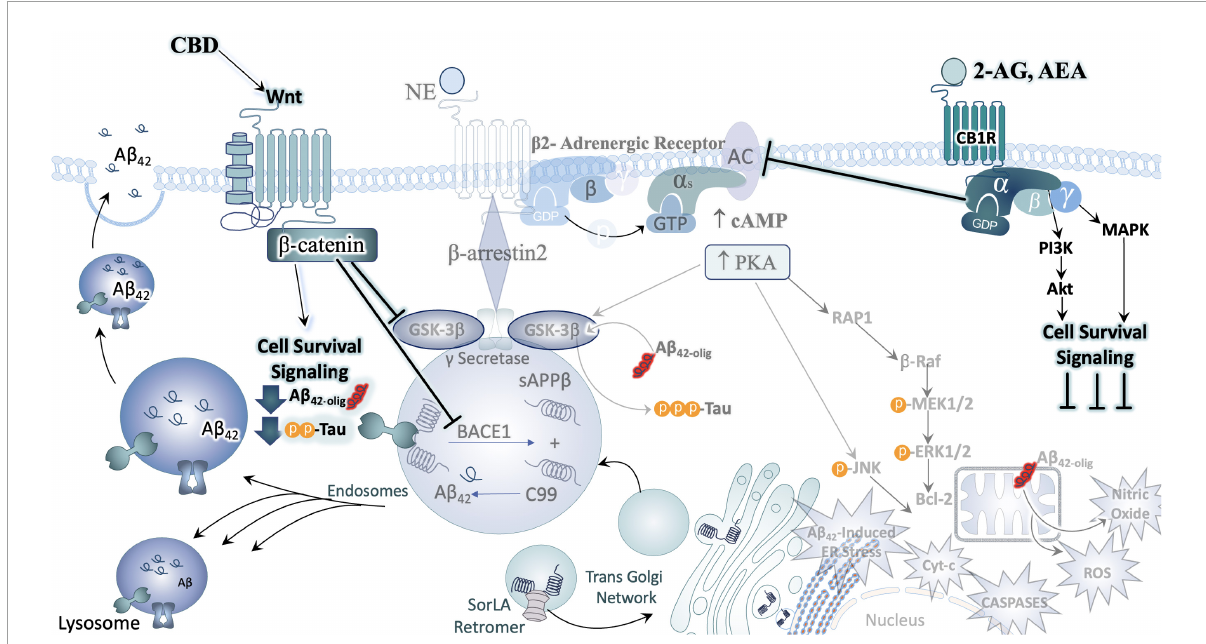
FIGURE6 Cannabinoids counteract AD neuropathology exacerbated by stress. In direct opposition to (chronic) stress-responsive intracellular signaling cascades such as those downstream of the adrenergic receptors (ARs) or CRFR1, Cannabinoids inhibit cell signaling cascades that promote neuronal cell death. A major effector engaged by cannabidiol (CBD) exposure is the Wnt/ β -catenin pathway. By binding its cognate receptor and co-receptor, Wnt increases the level of stable intracellular β -catenin proteins. β -catenin then goes on to inhibit GSK3 β , the enzyme responsible for the upregulation of tau-phosphorylation, inhibit the beta-secretase (BACE-1), and promote the neuroprotective alpha-secretase cleavage of APP (not depicted here). Moreover, activation of CB1 receptors (CB1R) can counteract excessive stimulatory G-alpha subunit signaling by inhibiting adenylyl cyclase (AC) activity. By engaging the mitogen activated protein kinase (MAPK) and Akt pathways, CB1R signaling instead promotes the production and release of protective, cell survival